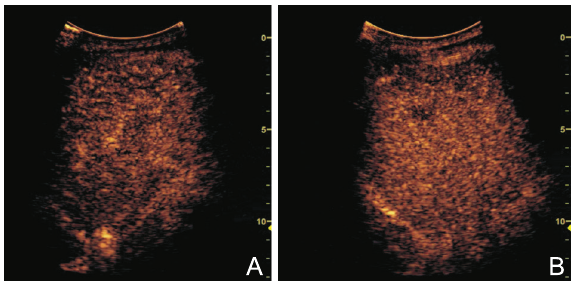
Figure. 1 A, the lesion doesn’t show washing-in in arterial phase (at 31s). B, the lesion shows wash-out in portal and lateral phase (at 1min 2s). Patient was in the horizontal position and